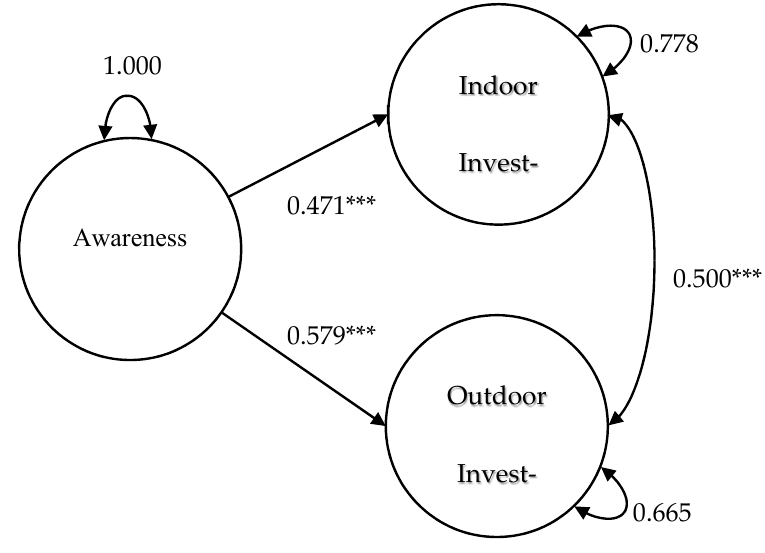
Figure 3. Model of owning water-saving appliances for indoor and outdoor usage regressed on awareness of water supplies for non-well owners ( n = 448).